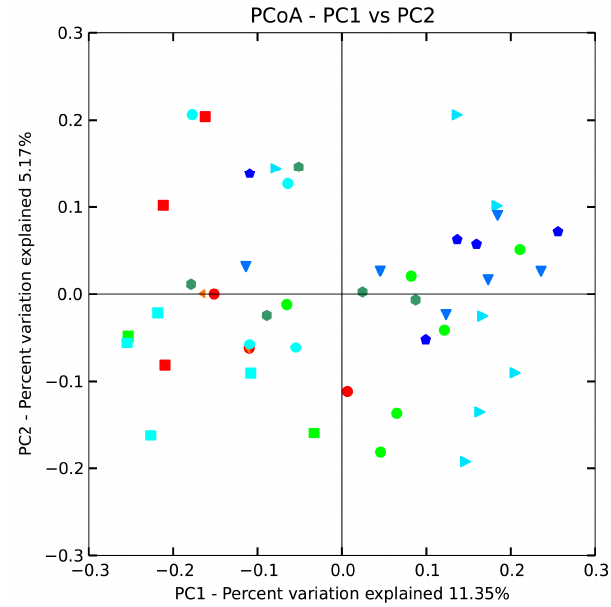
Figure 5. Principal coordinates analysis (PCoA) plots based on unweighted UniFrac metric. Each colored symbol represents the composition of fecal microbiota of one mouse. Symbol: